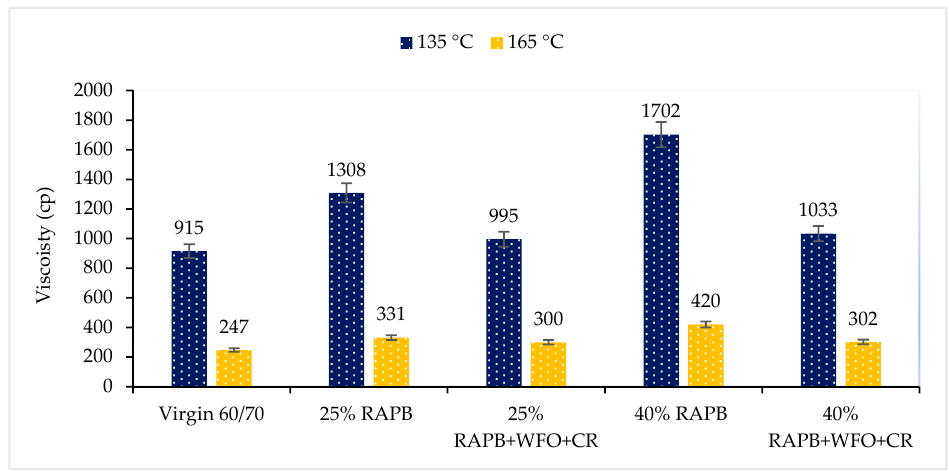
Figure 7. Viscosity results for two different temperatures.